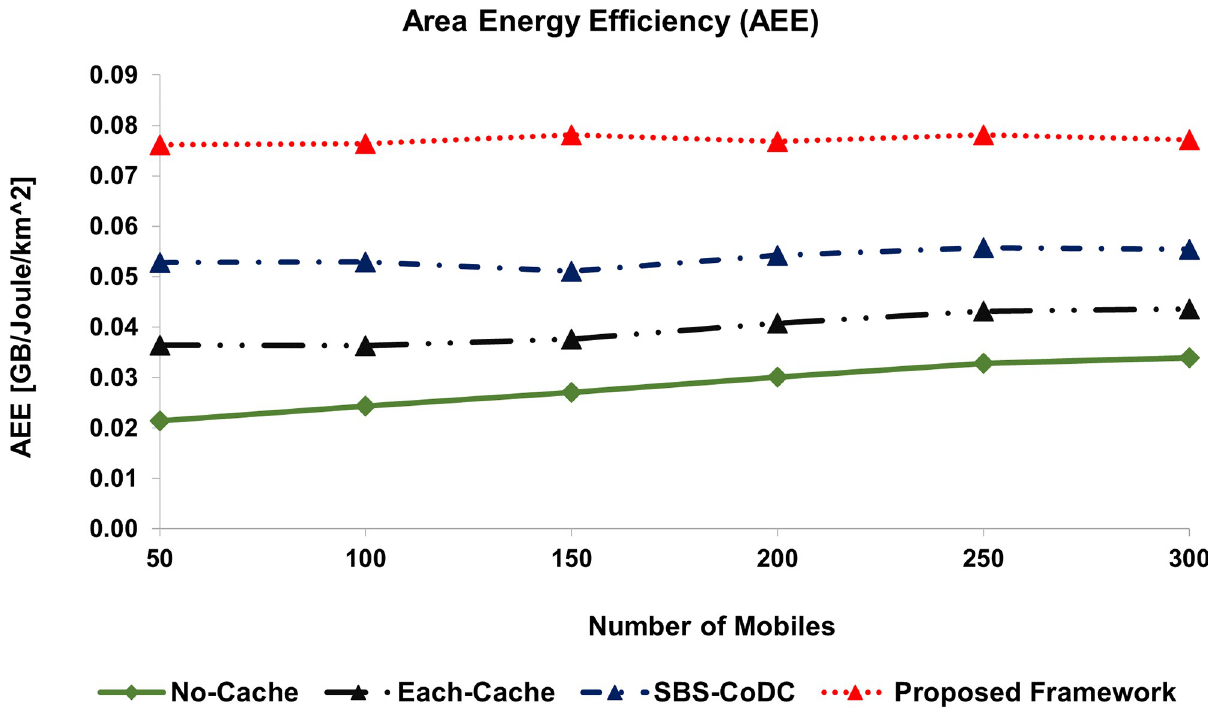
Fig 12. Comparison AEE based on uplink data rate and EC of the overall network.